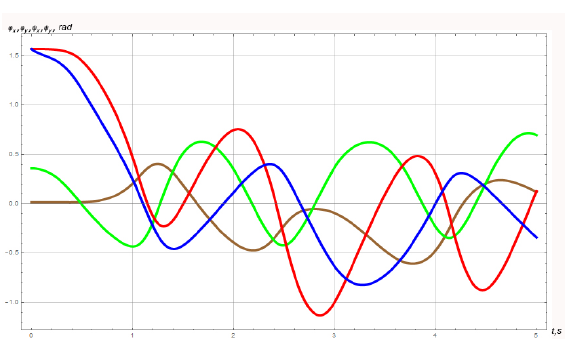
Figure 16. Dynamics of the crane trolley movement in y 1 -t coordinates